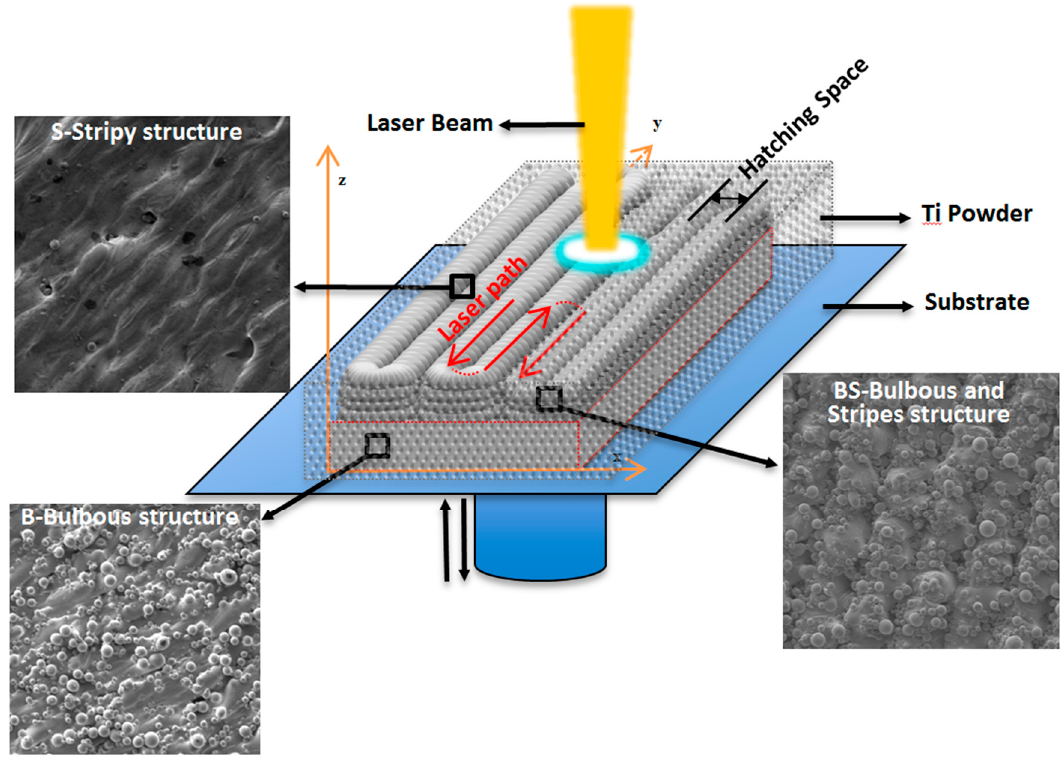
Figure 9. Schematic of the formation of three typical surface structures by regulating the 3D printing parameters.